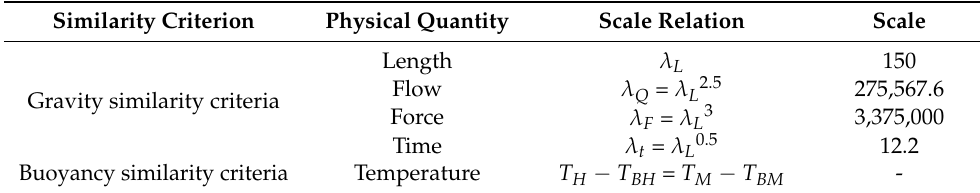
Table 2. Main experimental parameters and geometric